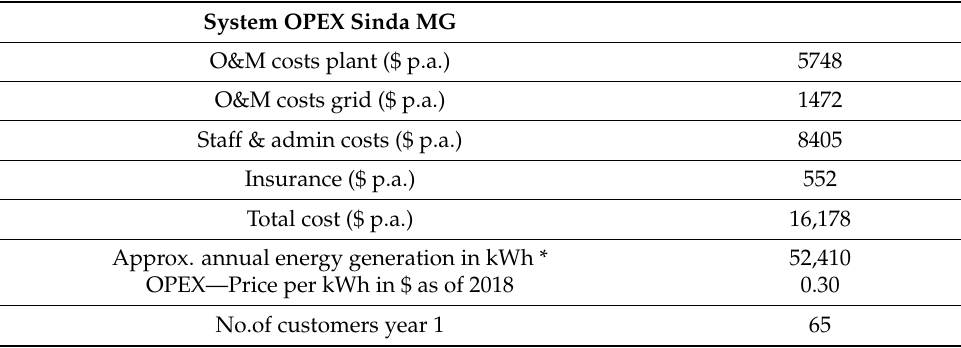
Table 6. Overview estimated OPEX costs of Sinda Mini-Grid, 2018